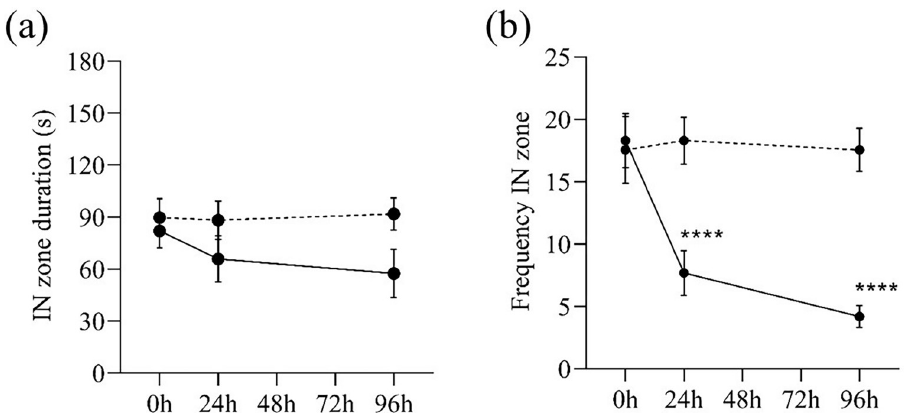
The amount of time spent in the IN zone when compared to the OUT zone and the fre- quency with which it is visited is a type of swimming pattern that reflects the exploratory behaviour of a zebrafish. In our observation, although both the control and MPTP-injected zebrafish spent half of the time at the center of the assay tank and the other half circling the tank wall (Fig 6A), however, the MPTP-injected zebrafish appeared to switch between the cen- ter and the wall less frequently (Fig 6B), suggesting that they preferred to swim close to their initial position rather than exploring the surroundings.